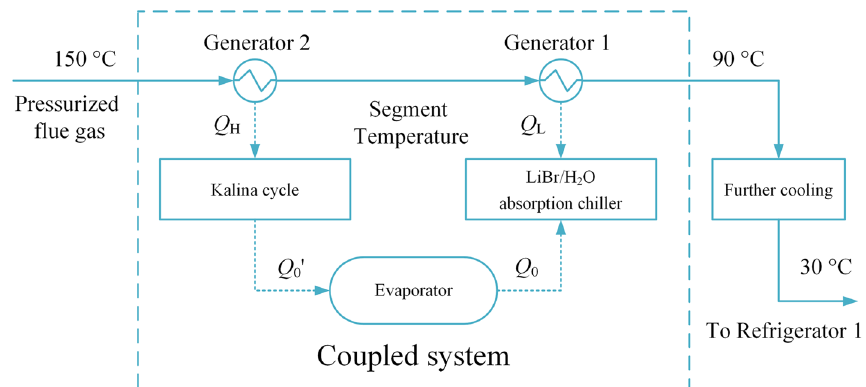
Fig. 3 Schematic diagram of the waste heat recovery